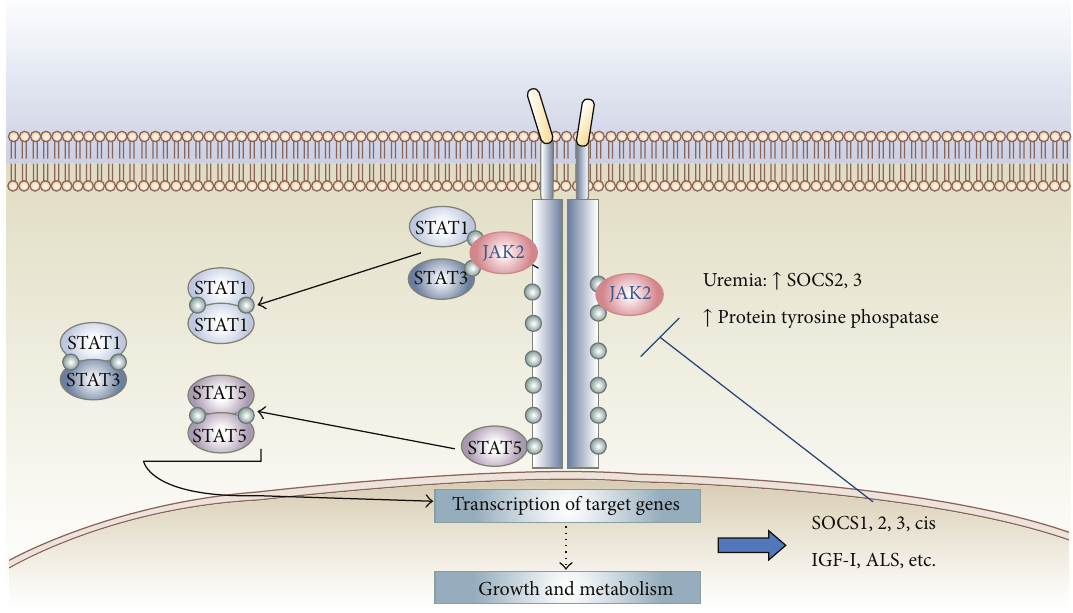
Figure 1: Growth hormone resistance in uremia: role for impaired JAK/STAT